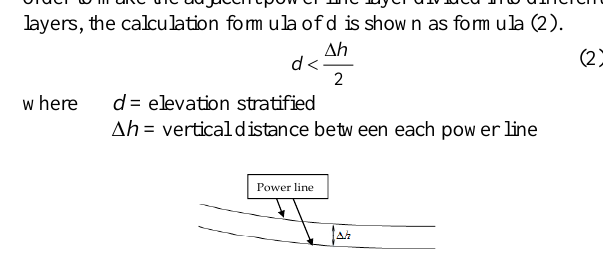
Figure 3. Vertical distance between power lines.